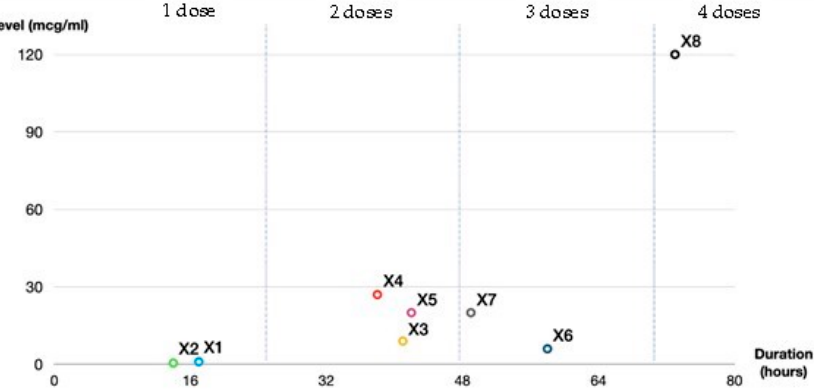
Figure 2. Bar chart comparison of absolute fecal ceftriaxone levels (mcg/mL) at baseline and after mixing with conventional activated charcoal (AC) at different doses: low dose (30 mg/g feces), in- termediate dose (150 mg/g feces), and high dose (500 mg/g feces) .